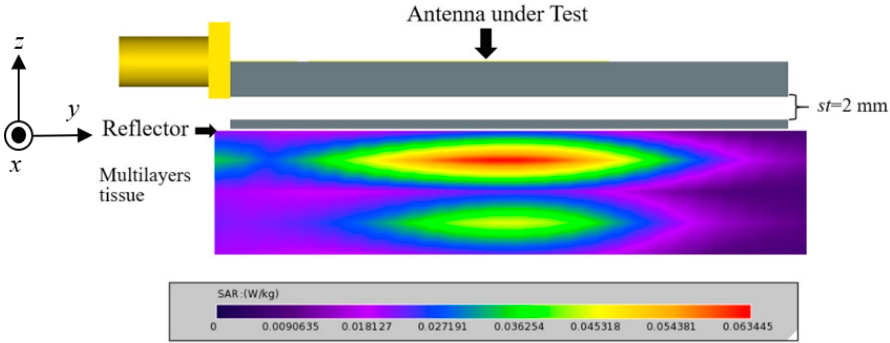
Figure 12. Specific absorption rate (SAR) simulation setup to calculate electromagnetic energy absorbed by human tissue.